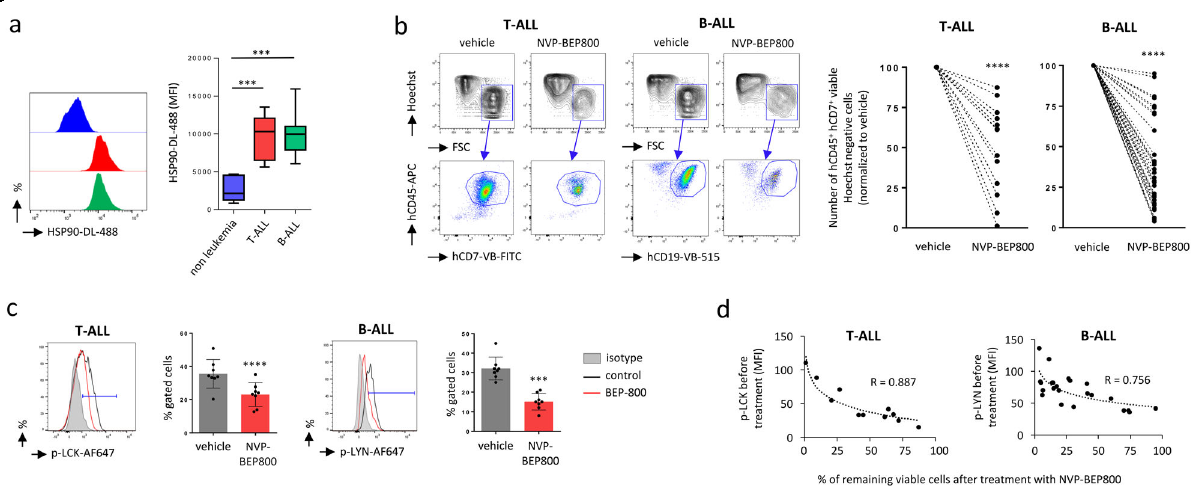
Fig. 3 Primary T-ALL and B-ALL cells are sensitive to NVP-BEP800. a Flow cytometry on primary T-ALL (CD45 + hCD7 + , n = 10), B-ALL (hCD45 +